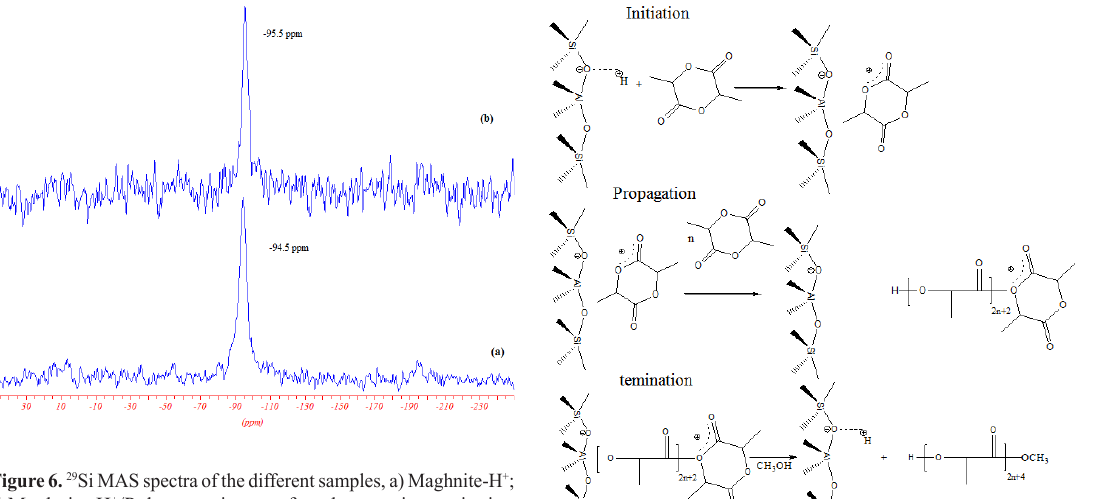
Figure 6. 29 Si MAS spectra of the different samples, a) Maghnite-H + ; (bMaghnite-H + /Polymer mixture after the reaction, spinning frequency : 10